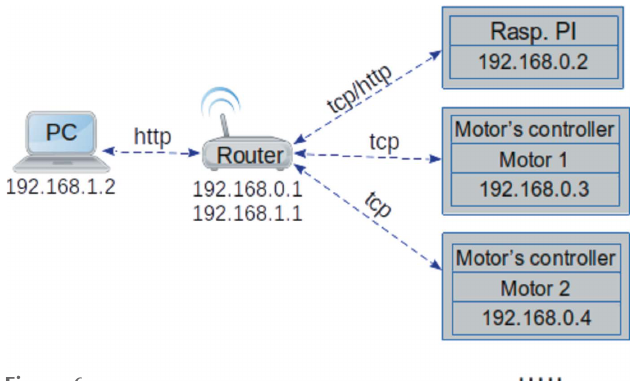
Figure 6 Schematics of the local network to control the XES spectrometer.